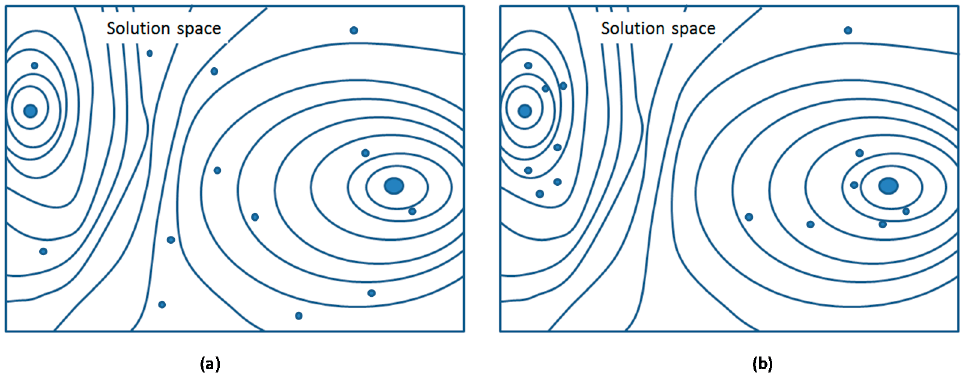
Figure 7. ( a ) Random mutations vs. ( b ) Oriented mutations.